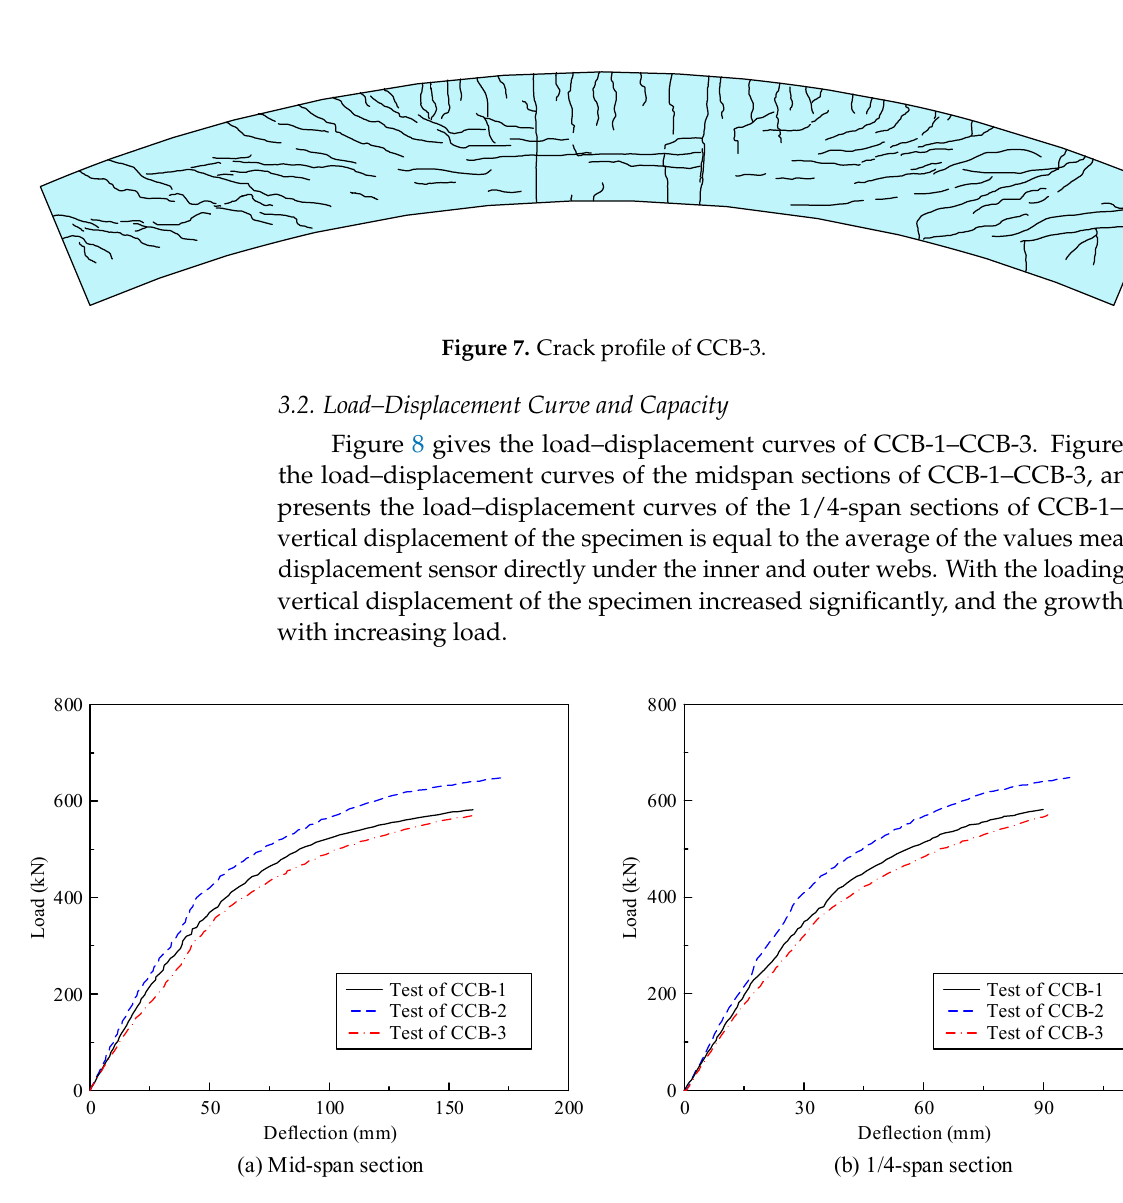
Figure 8. Load–deflection curves of the test specimens.